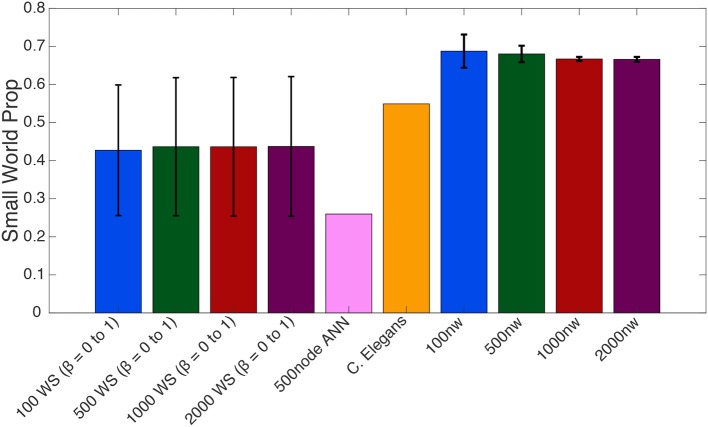
Average small–world propensity values for Watts-Strogatz (WS), 500-node ANN, C. elegans and ASNs of varying sizes (number of nanowires, nw). Averages for WS were taken across all 21 β parameters from 0 to 1, with error bars reflecting standard deviation across β parameters. Averages for ASNs were taken from 39 networks with varying parameters as described in the methods section, with error bars reflecting standard deviation across network parameters.